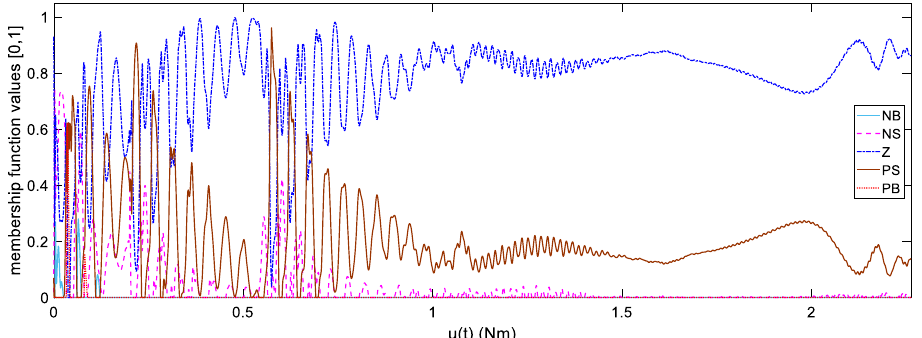
Figure 17. Membership function value of the fuzzy set u(t) corresponding to the physical value domain of u(t) is selected as in Table 6.